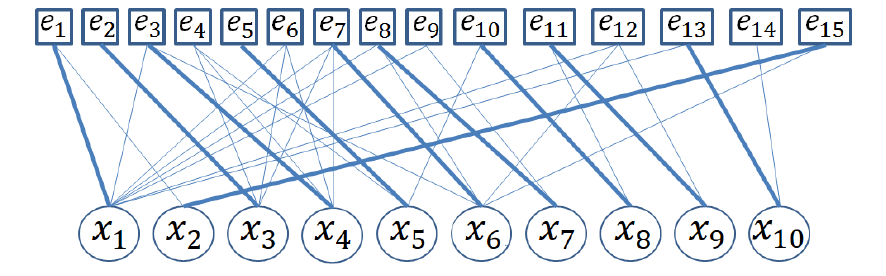
Figure 2. X -complete